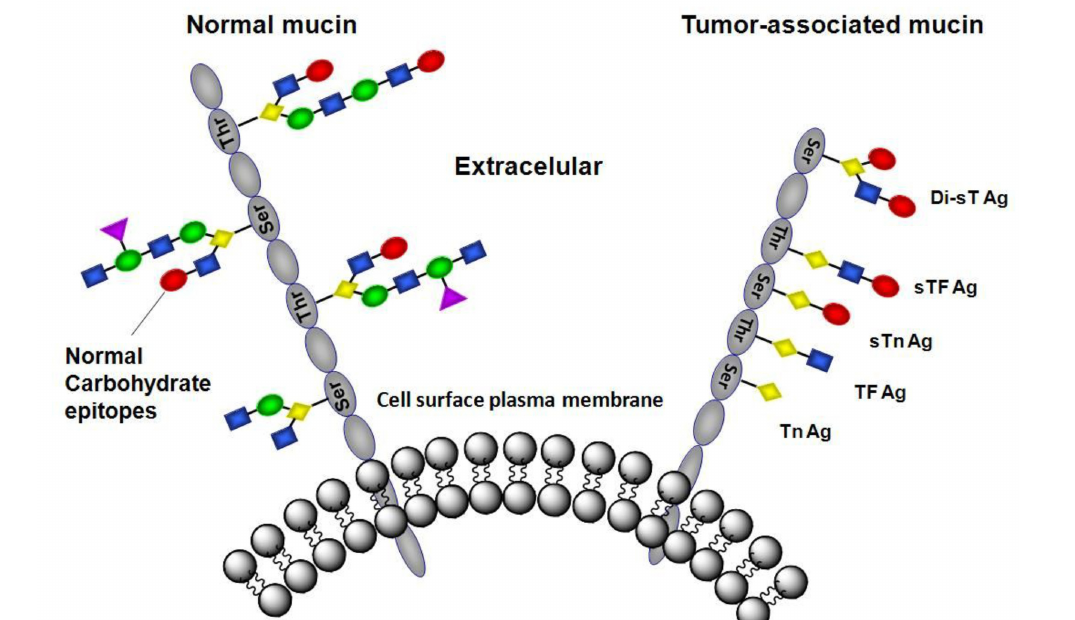
FIGURE 4 – Carbohydrate structures of mammalian cell surface mucins in healthy and cancer cells. Glycosylation patterns are much more elaborated in healthy mucins, thus masking key tumor associated carbohydrate antigens that become heavily exposed in